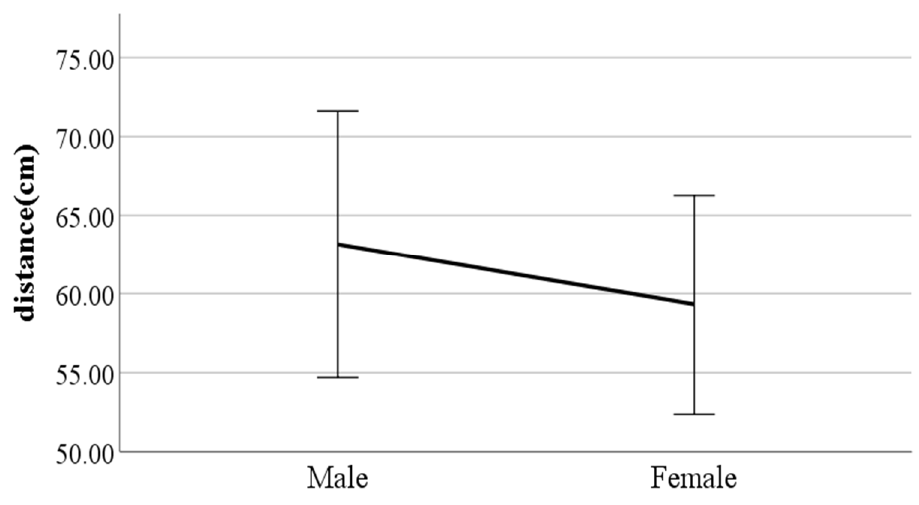
Figure 7. Gender difference in step length (F value: 5.78, DF: 289, p -value: 0.00).